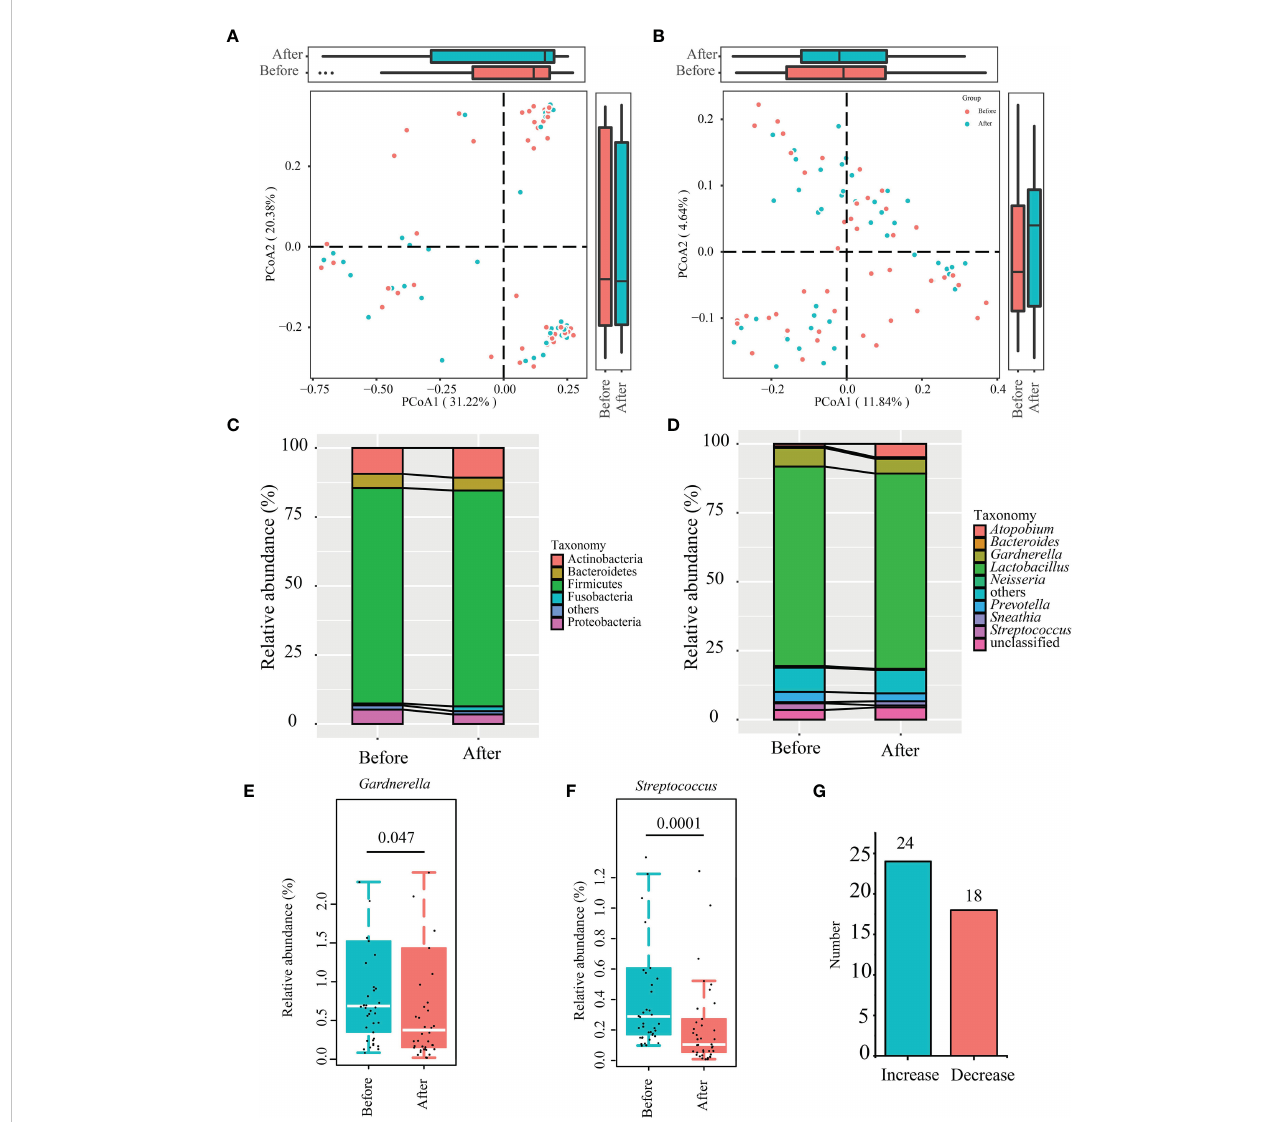
FIGURE 3 Changes in the b -diversity of vaginal microbiota and differential abundant bacteria identi fi ed after using the postbiotic gel. (A, B) Principal co-ordinates analysis (PCoA; weighted and unweighted unifrac) of subjects ’ vaginal microbiota. (C) Phylum- and (D) genus-level taxonomic pro fi les of subjects ’ bacterial vaginal microbiota before and after applying the postbiotic gel. (E, F) Box plots of the differential abundant bacterial genera, Gardnerella and Streptococcus before and after using the postbiotic gel. (G) The number of people with changes in Lactobacillus